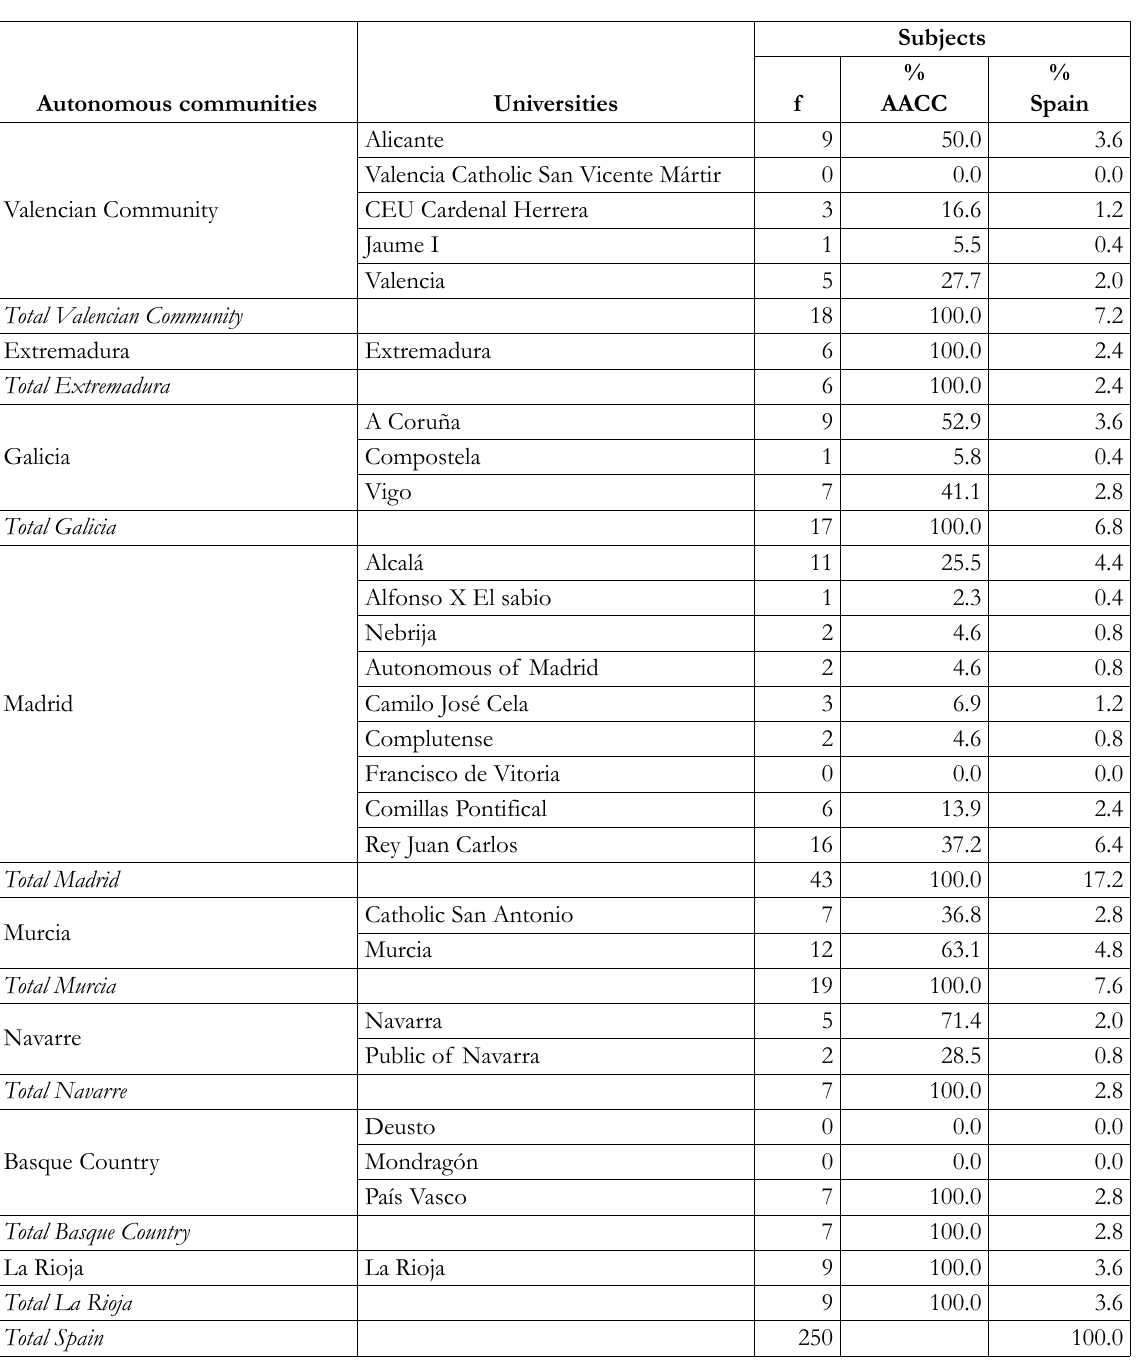
Table 3. Subjects with content on the didactic use of cinema according to the Autonomous Community and the